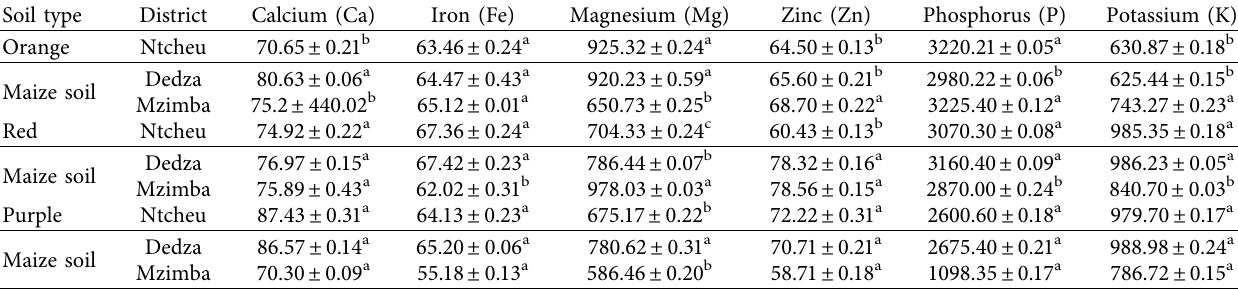
Table 3: Mineral content (mg · kg − 1 ) of soil samples grown with